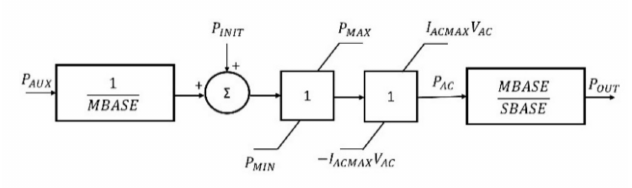
Figure 4. Active power control of Battery Energy Storage System (BESS).